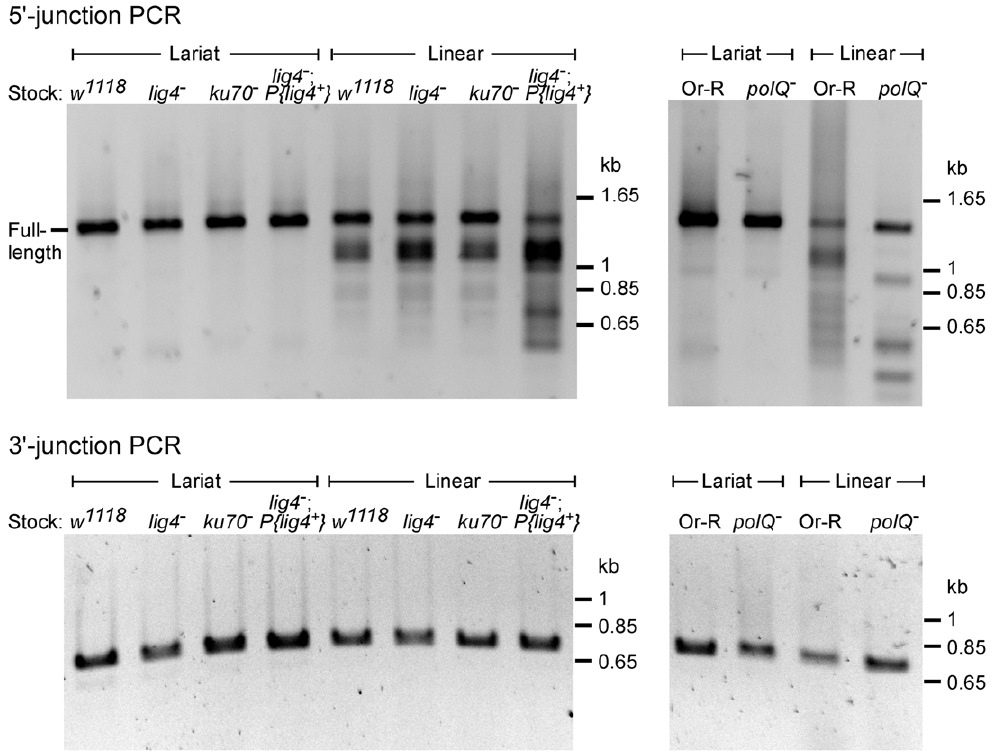
Figure 3. PCR analysis of integration junctions from lariat and linear intron RNA retrohoming in wild-type and mutant strains. Retrohoming assays with lariat and linear RNPs were done as described in Figure 2A and Materials and Methods, and DNA was extracted from 80 pooled embryos for each strain. 5 9 - and 3 9 -integration junctions were amplified by PCR, using primers that flank the junction (5 9 junction, forward primer P1 and reverse primer LtrB933a; 3 9 junction, forward primer P3 and reverse primer P4; see Materials and Methods). The PCR products were analyzed in a 1% agarose gel, which was stained with ethidium bromide. Precise 5 9 and 3 9 junctions for lariat intron RNA retrohoming and precise 3 9 junctions for linear intron RNA retrohoming were confirmed by sequencing junctions from at least 10 randomly selected Tet R + Amp R colonies or PCR products from pooled embryos for all strains (not shown).